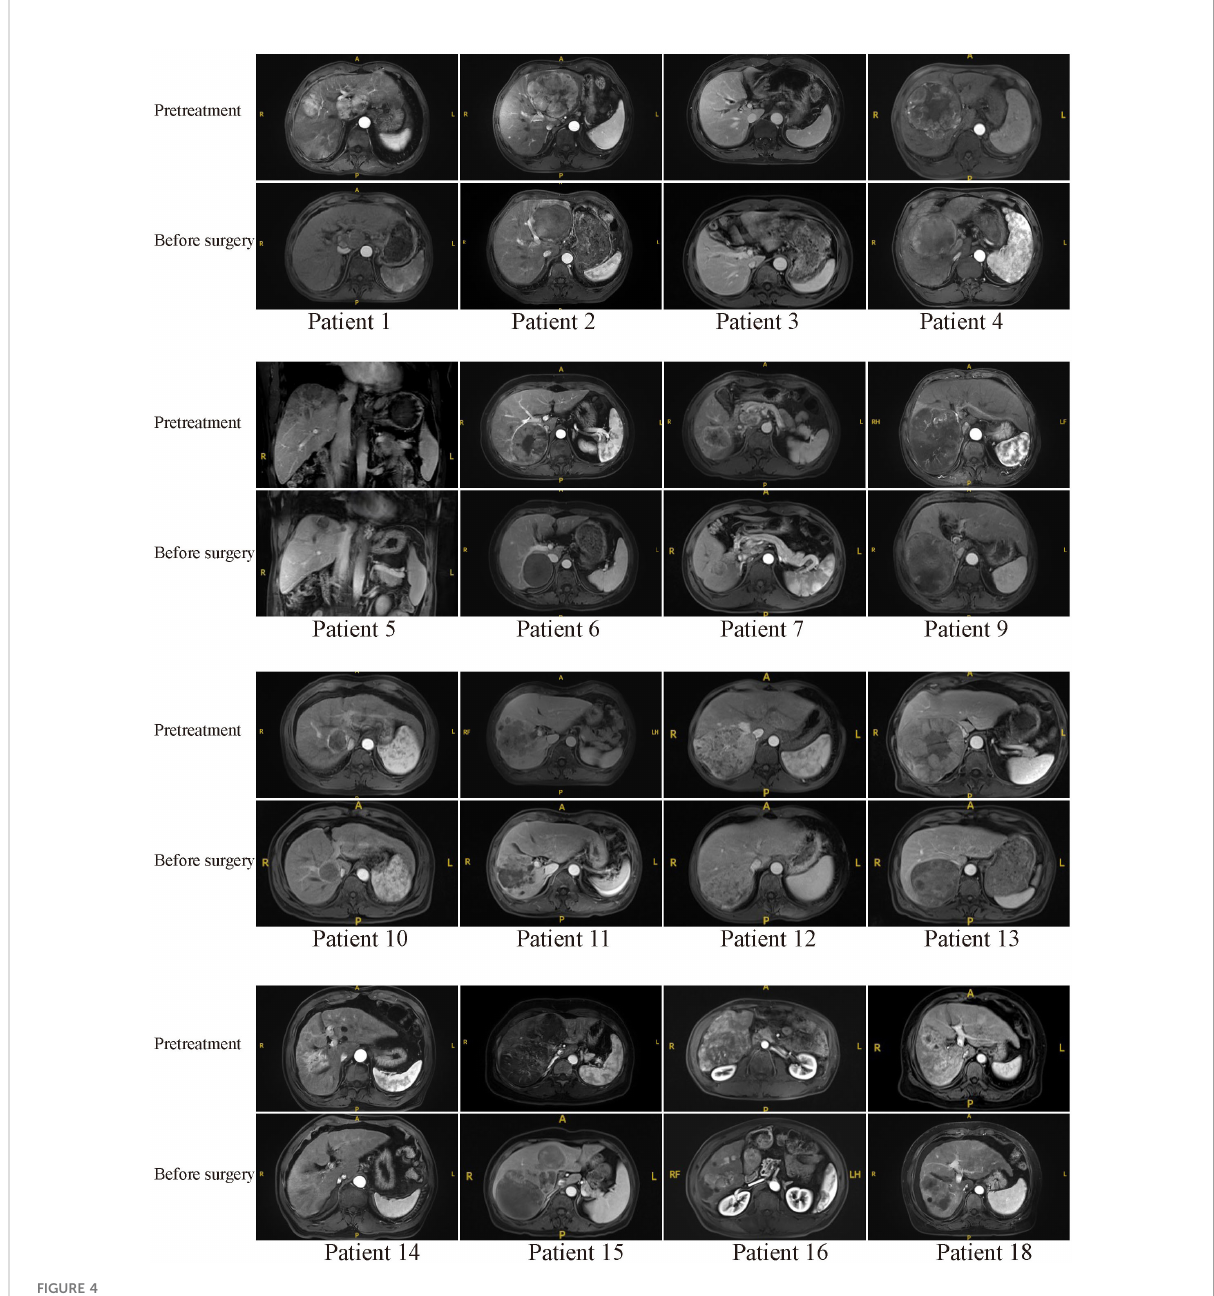
FIGURE 4 Pretreatment and preoperative MR scans of patients 1-18 (except patients 8 and